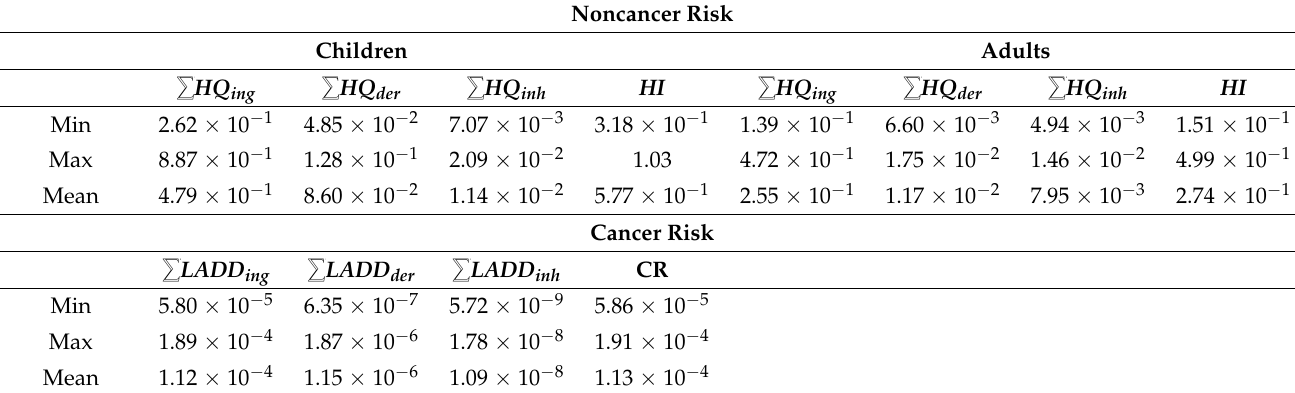
Table 5. Integrated noncancer and cancer risks values. Figure 7. ( a ) Boxplots of noncancer risk for children; ( b ) for adults; ( c ) pie chart showing individual Figure 7. ( a ) Boxplots of noncancer risk for children; ( b ) for adults; ( c ) pie chart showing individual Figure 7. ( a ) Boxplots of noncancer risk for children; ( b ) for adults; ( c ) pie chart showing individual Figure 7. ( a ) Boxplots of noncancer risk for children; ( b ) for adults; ( c ) pie chart showing individual Figure 7. ( a ) Boxplots of noncancer risk for children; ( b ) for adults; ( c ) pie chart showing individual Figure 7. ( a ) Boxplots of noncancer risk for children; ( b ) for adults; ( c ) pie chart showing individual element contribution (%) for noncarcinogenic risk. element contribution (%) for noncarcinogenic risk. element contribution (%) for noncarcinogenic risk. element contribution (%) for noncarcinogenic risk. element contribution (%) for noncarcinogenic risk. element contribution (%) for noncarcinogenic risk.